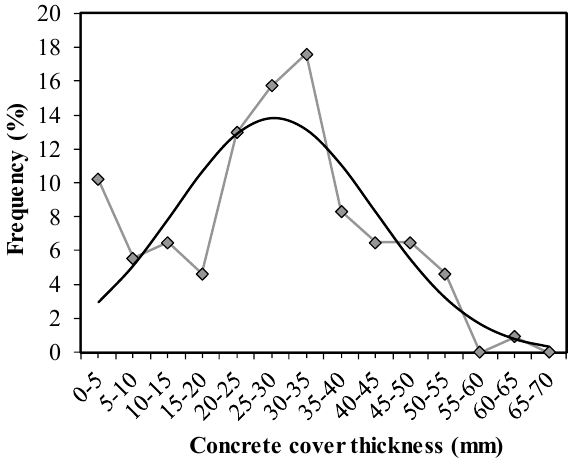
Figure 2. Imaginary frequency analysis (grey sym- bols) and probability density function (black line) of the concrete cover